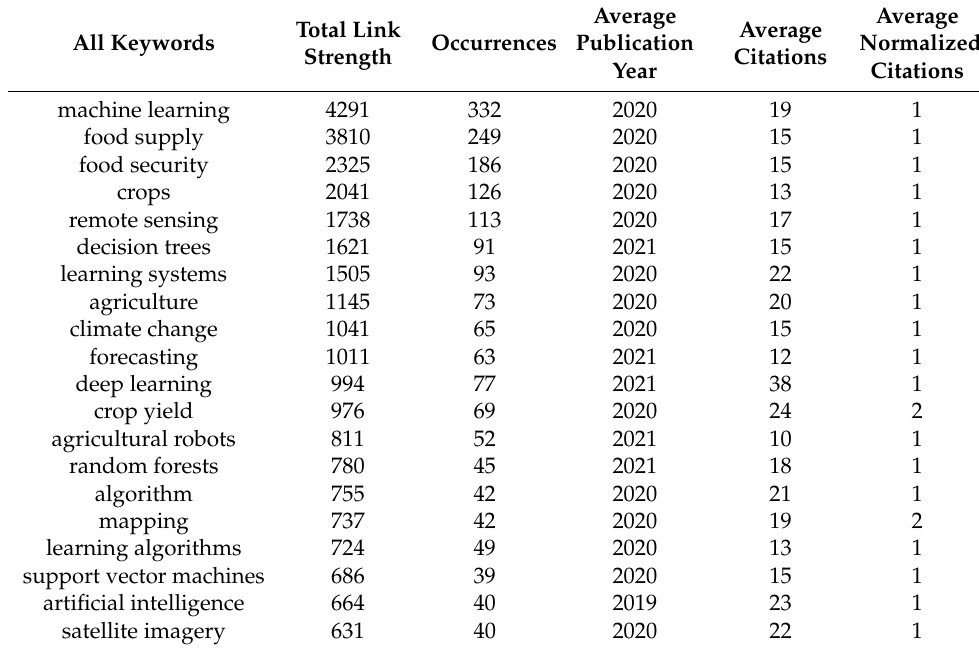
Table 2. Top 20 all keywords with the highest total link strength for bibliographic data, considering full counting and 1 as the minimum number of occurrences of a